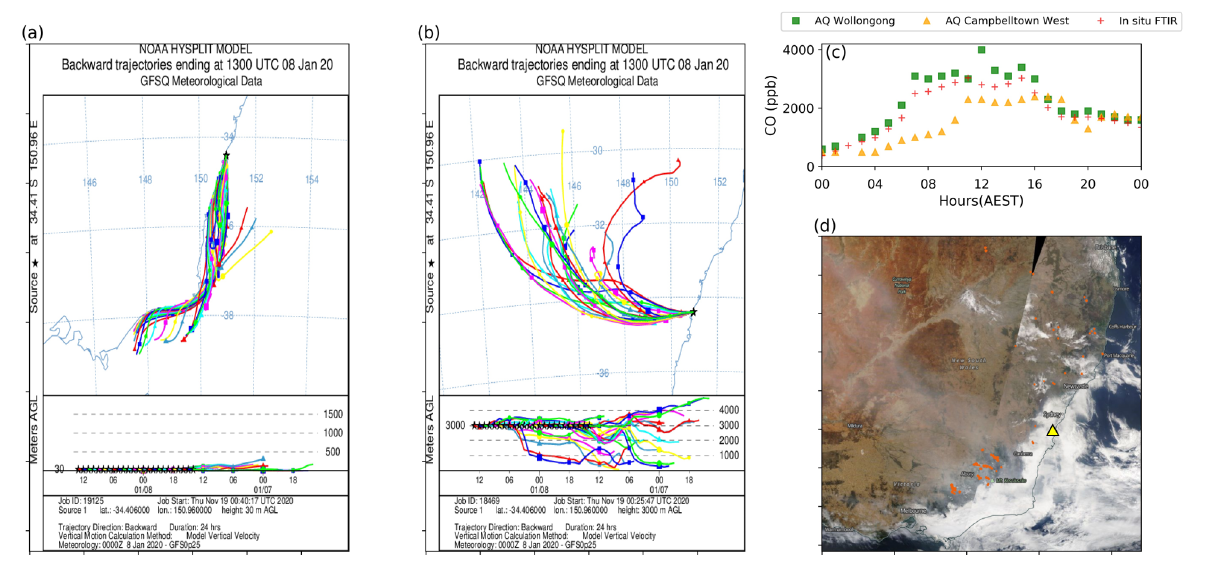
Figure 12. 8 January 2020: 24 h NOAA HYSPLIT back trajectories (UTC) at ( a ) 30 m and ( b ) 3000 m; ( c ) Hourly averaged surface in situ CO measurements at Wollongong air quality monitoring site (green squares), Campbelltown West air quality monitoring site (yellow triangles) and Wollongong in situ FTIR (red crosses). Black and grey dots show hourly averaged column CO measurements (TCCON & NDACC) and all native temporal resolution column measurements, respectively (in AEST: UTC + 10 h). ( d ) MODIS hotspot image with thermal anomalies [68] (zoomed in for southeast Australia). The UOW measurement site is marked with a yellow